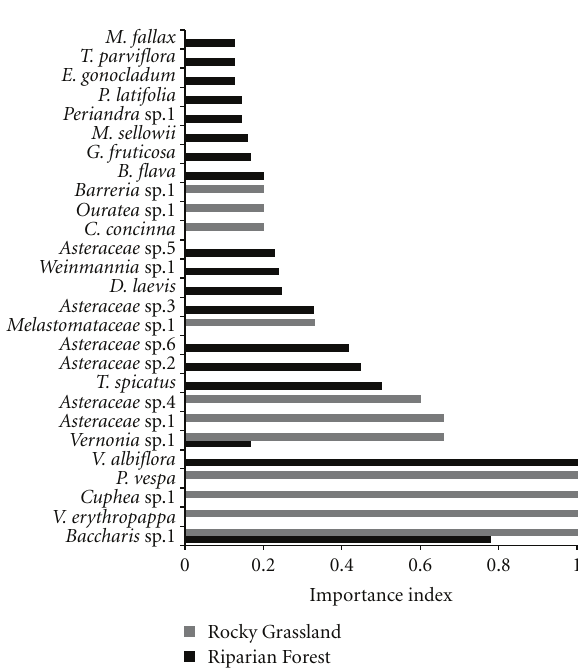
Figure 3: Specialization index of social wasp species in the two areas of Ibitipoca State Park (Riparian Forest and Rocky Grassland), MG, Brazil, during the period from November 2007 to October